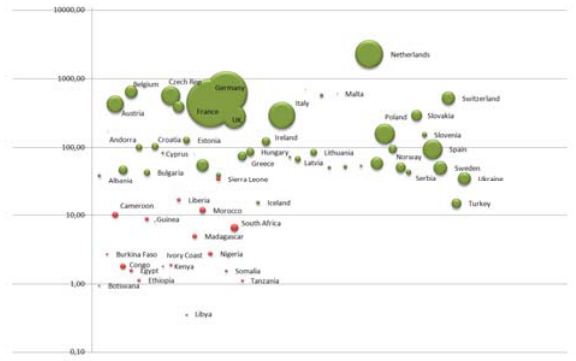
Figure 1. OSM data size for African & European countries. Bubble size equals data size (Moeller & Fuhrmann,